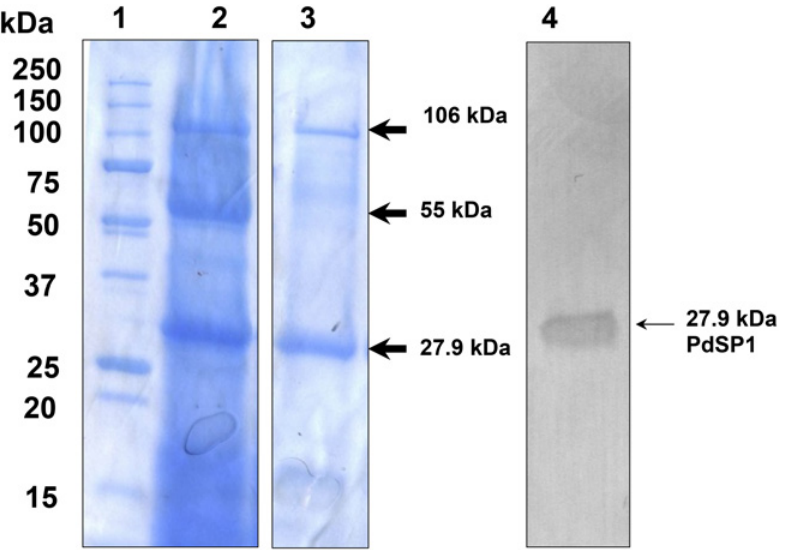
Fig 4. SDS-PAGE of P . destructans extracellular proteins separated by ConA lectin affinity chromatography. Lane 1, Biorad Precision Plus mass standards; lane 2, Crude enzyme substrate; lane 3, ConA elution (from non-adjacent gel lane); lane 4, western blot analysis detection in enriched protein concentrate using a PdSP1 antiserum.